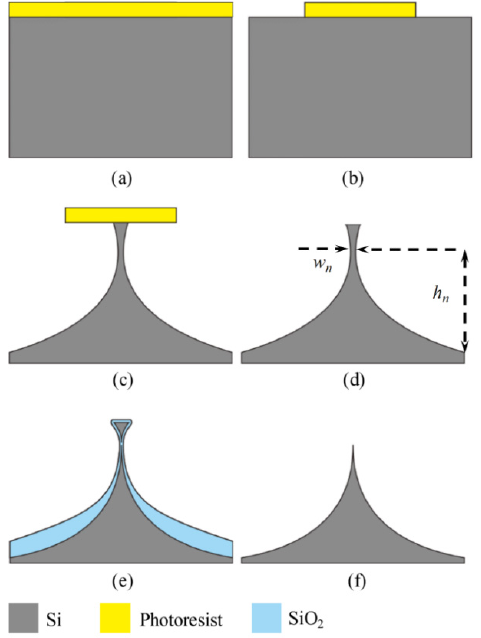
Figure 1. Fabrication process flow for silicon tips. ( a ) photoresist layer as etching mask, ( b ) patterning the photoresist layer, ( c ) isotropic etching of silicon, ( d ) removal of the mask, ( e ) thermal oxidation, ( f ) removal of the oxide layer.